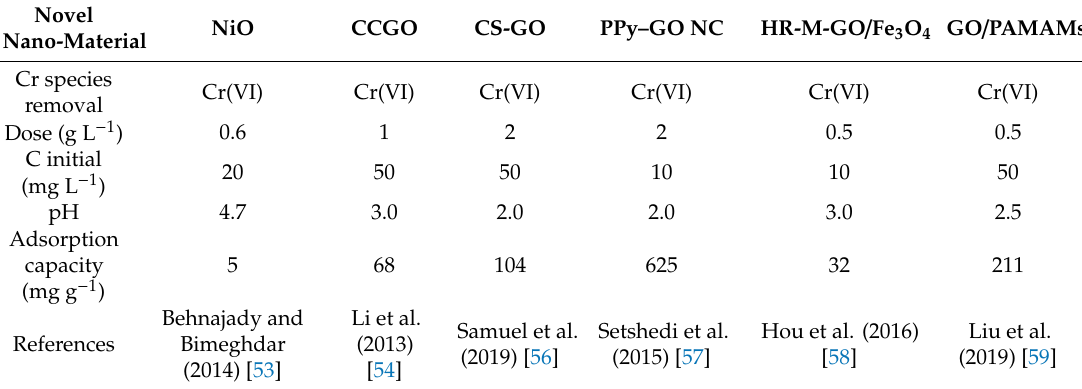
Novel nanostructured materials applied for the removal of chromium mainly from wastewater sources.